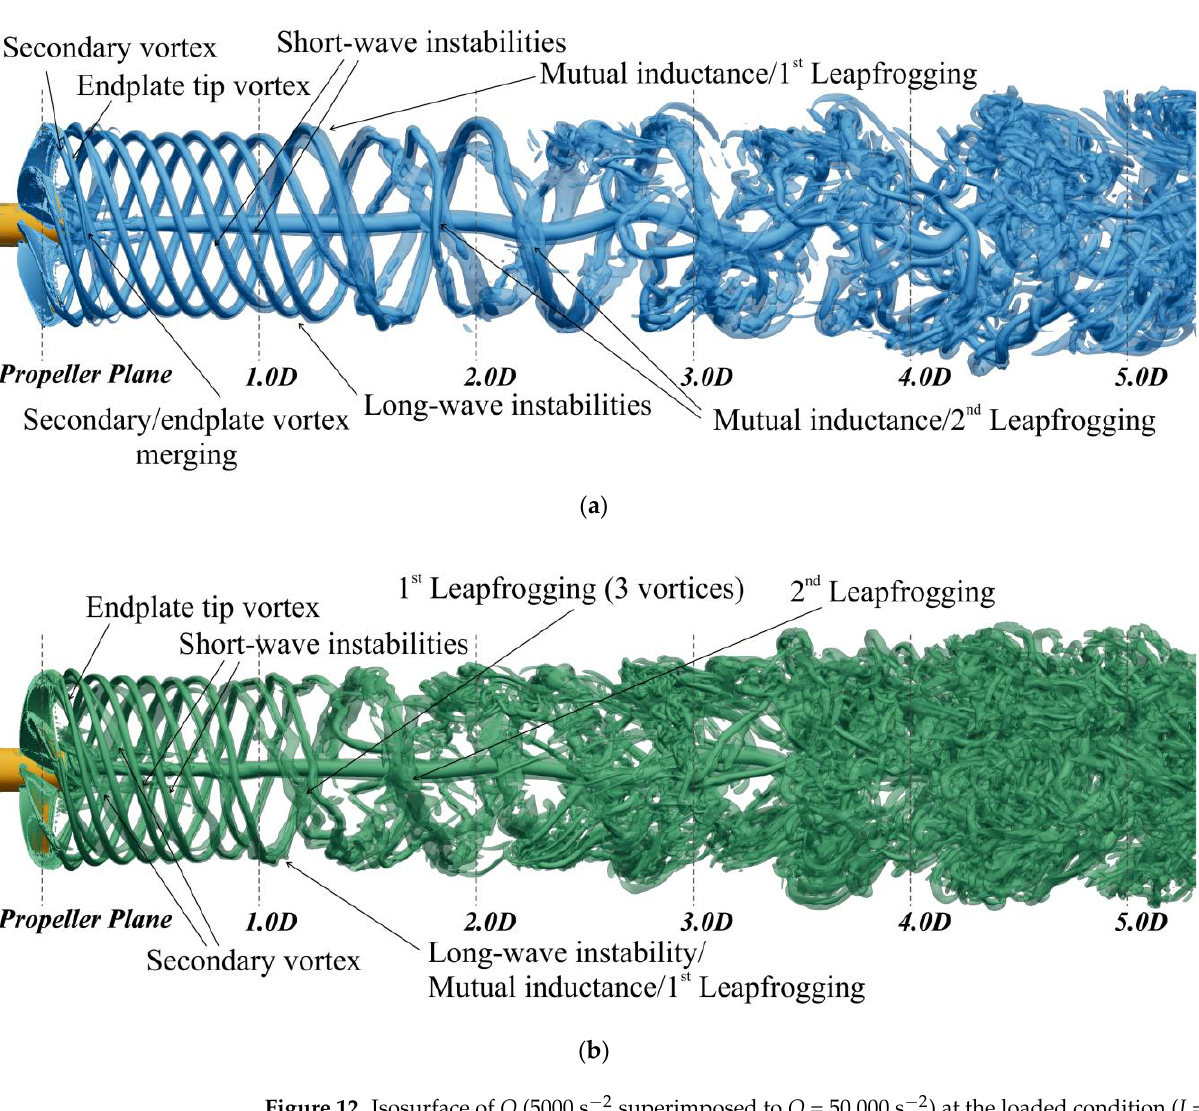
Figure 12. Isosurface of Q (5000 s −2 superimposed to Q = 50,000 s −2 ) at the loaded condition ( J = 0.6). General overview. ( a ) Conventional CLT propeller; ( b ) New generation CLT